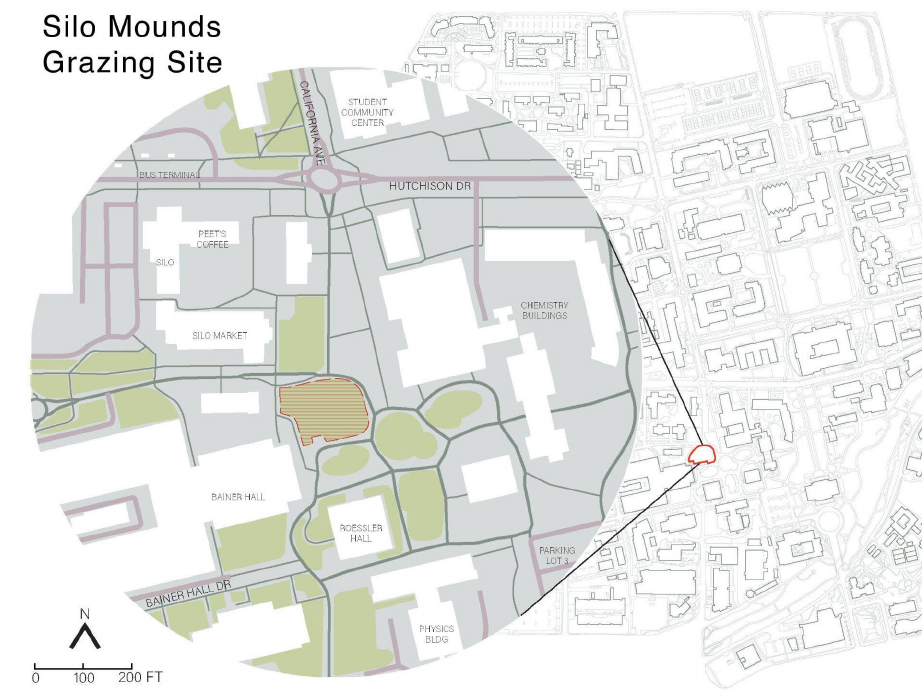
Figure 1. UC Davis campus map, with grazing site enlarged.